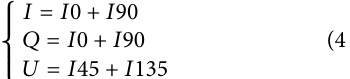
output intensity and polarization information of each image pixel [23]. Speci fi c parameters of the LUCID polarization camera are